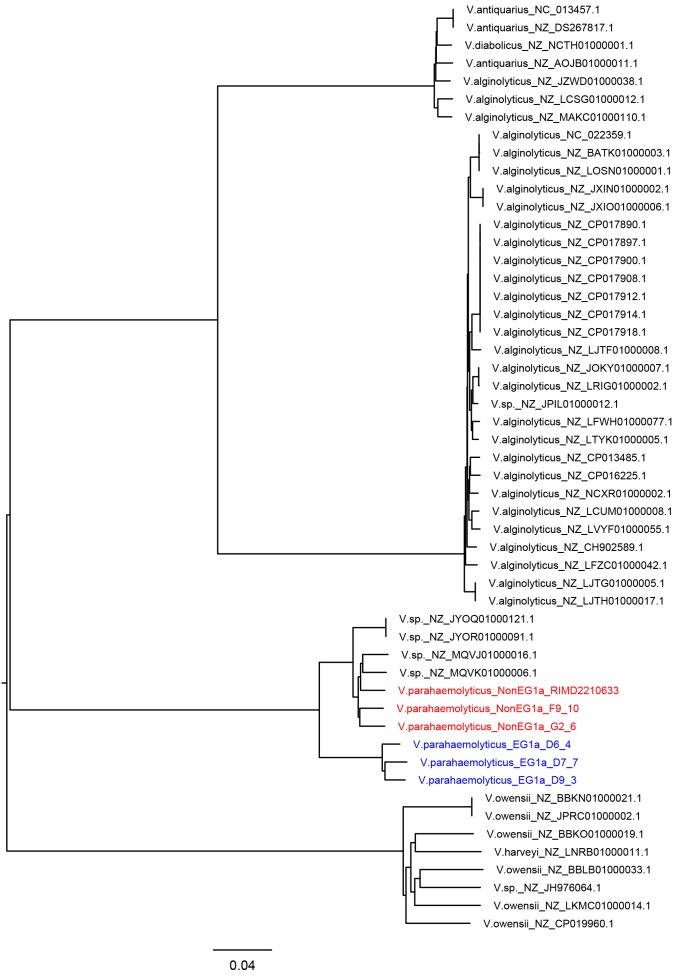
NJ tree of lateral flagellar gene cluster region (VPA1538-1557) in Vibrio genus.Three randomly selected strains of EG1a and NonEG1a are used and marked in blue and red, respectively.